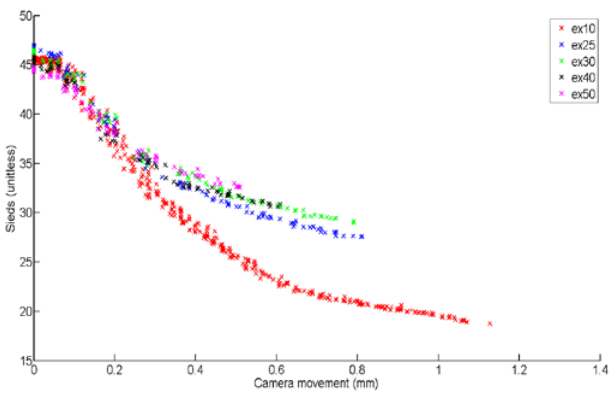
Figure 10. Camera displacement in comparison to sieds.